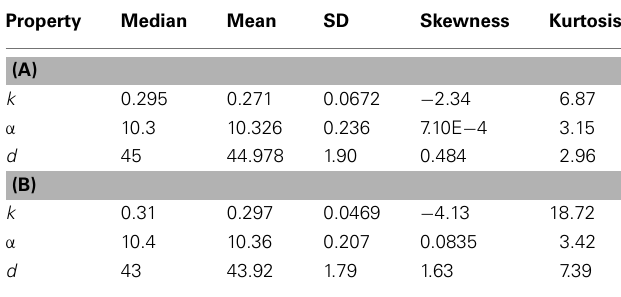
Table 7 | Properties of the distributions of median values of cancer cells among 500 tumors derived from (A)TICC and